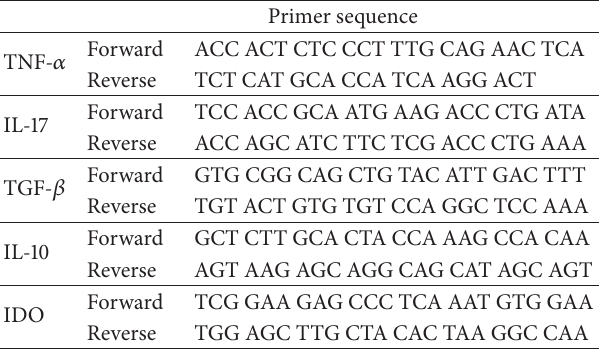
Table 1: Sequences of primers for RT-PCR. Primer